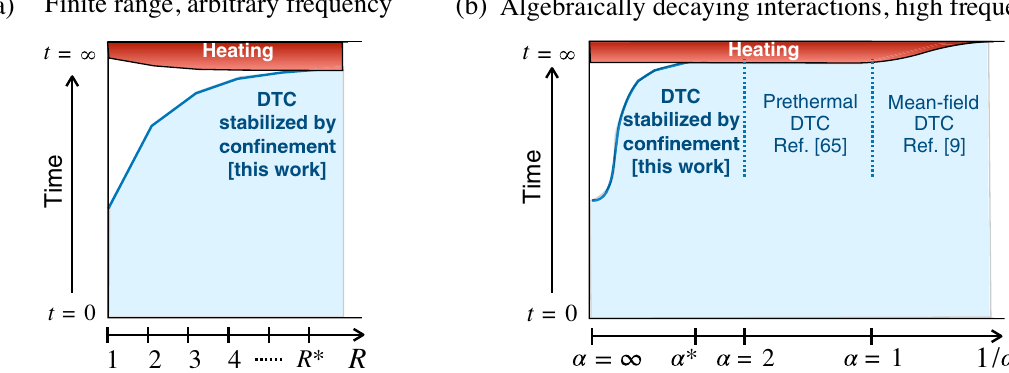
FIG. 2. Sketch of the timescales involved in this work and beyond. (a) Finite interaction range R and arbitrary driving frequency [Eq. (40)]. Here, we fix ϵ ≪ 1 . The blue region denotes the extent of the DTC lifetime window upon increasing R ; the blue upper boundary is the timescale 1 = γ ∼ ϵ − ð 2 R þ 1 Þ proved in this work [Eq. (48)]. The heating region ’ s lower boundary represents the lower bound ≥ exp ð C= ϵ 1 = ð 2 R þ 1 þ δ Þ Þ on the heating timescale [Eq. (55)]. The crossing point R (cid:2) ¼ R (cid:2) ð ϵ Þ is pushed to ∞ (i.e., to the top-right T preth corner) as ϵ → 0 . (b) Algebraically decaying interaction and high driving frequency [Eq. (63)]. Here, we take ϵ ≪ J and fix a small τ . The blue region denotes the extent of the DTC lifetime window upon decreasing α . Left: For α > 2 , the blue upper boundary is the timescale 1 = γ ∼ ϵ − A ϵ − 1 = ð α − 2 Þ argued in this work [Eq. (62)]. The heating region ’ s lower boundary represents the lower bound ≥ exp ð C= τ Þ on the heating timescale, which is insensitive to the precise value of α > 1 ; see, e.g., Ref. [64]. The crossing T preth point α (cid:2) ¼ α (cid:2) ð ϵ ; τ Þ is slowly pushed to ∞ (i.e., to the top-left corner) as ϵ → 0 . Center: Prethermal DTC phase for 1 < α ≤ 2 , as established in Ref. [65]. Right: Mean-field DTC, established in Ref. [9] for infinite-range interactions α ¼ 0 . For 0 < α ≤ 1 , dynamics preserve the mean-field character for a timescale that diverges with system size; see Refs.